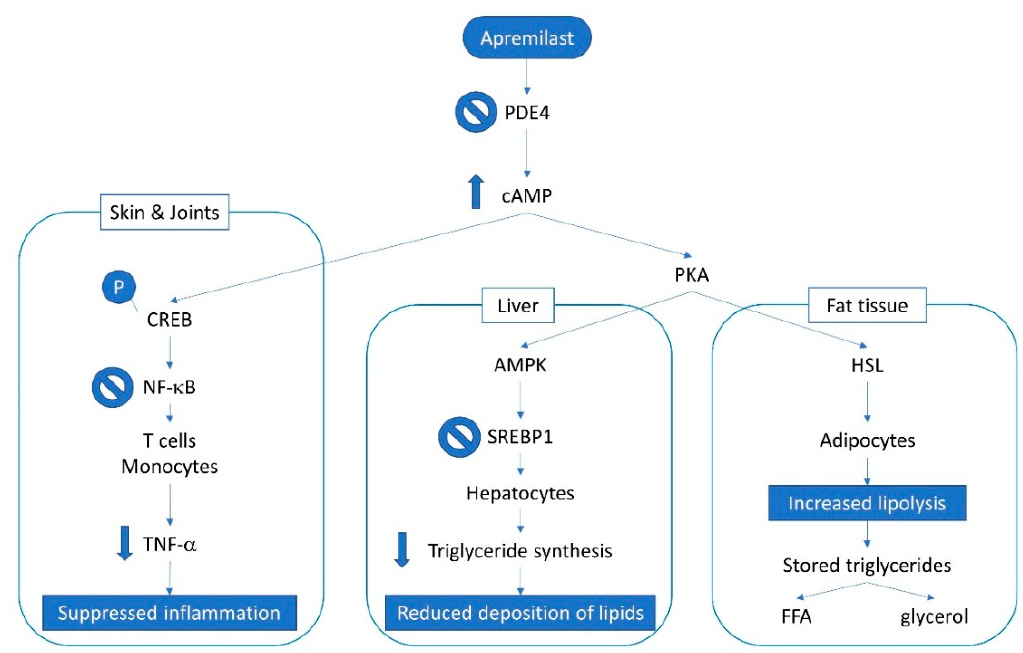
Figure 5. Overview of apremilast mechanism of action in psoriatic arthritis in different systems. Definitions: adenosine monophosphate kinase (AMPK); cyclic adenosine monophosphate (cAMP); cAMP response element-binding (protein) (CREB); free fatty acids (FFA); hormone-sensitive lipase (HSL); nuclear factor κ B (NF- κ B); phosphodiesterase 4 (PDE4); phosphokinase A (PKA); sterol regulatory element-binding protein 1 (SREBP1); tumor necrosis factor-alpha (TNF- α ).